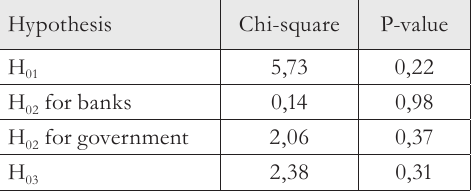
Tab. 2 - Statistical test of appointed hypotheses. Source: Authors’